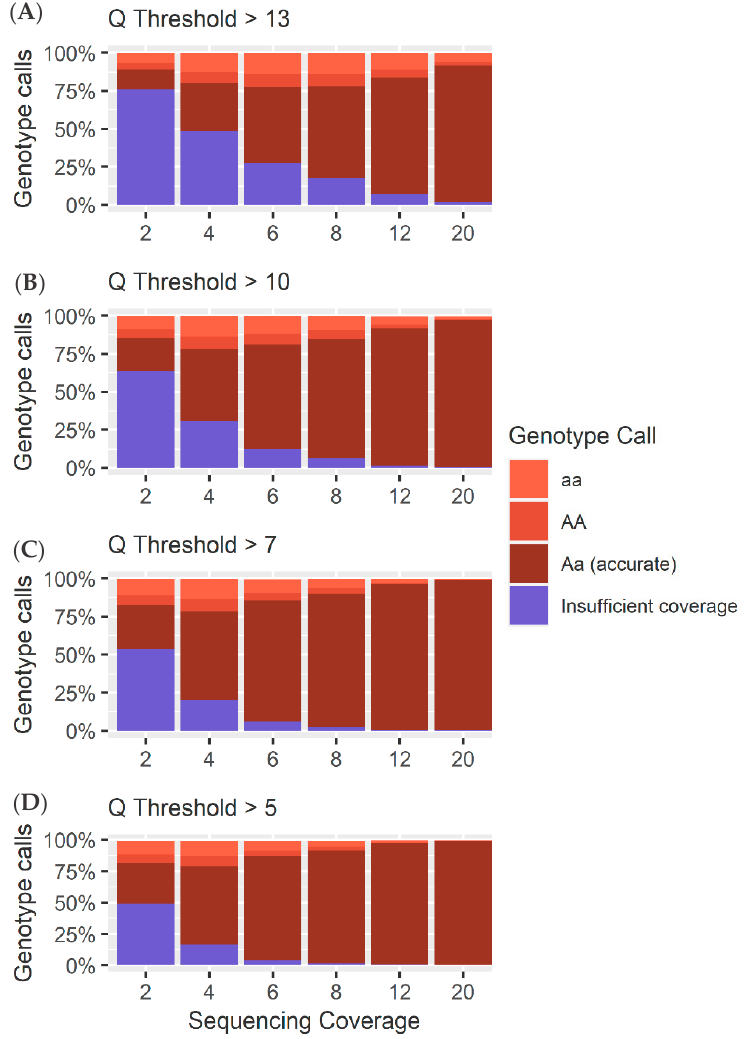
Figure 6. ( A ) A breakdown of the different calls (Table S2) for each sequencing coverage at a Q threshold of 13 for the 10,000 heterozygous loci. ( B ) A breakdown of the different calls (Table S2) for each sequencing coverage at a Q threshold of 10 for the 10,000 heterozygous loci. ( C ) A breakdown of the different calls (Table S2) for each sequencing coverage at a Q threshold of 7 for the 10,000 heterozygous loci. ( D ) A breakdown of the different calls (Table S2) for each sequencing coverage at a Q threshold of 5 for the 10,000 heterozygous loci.